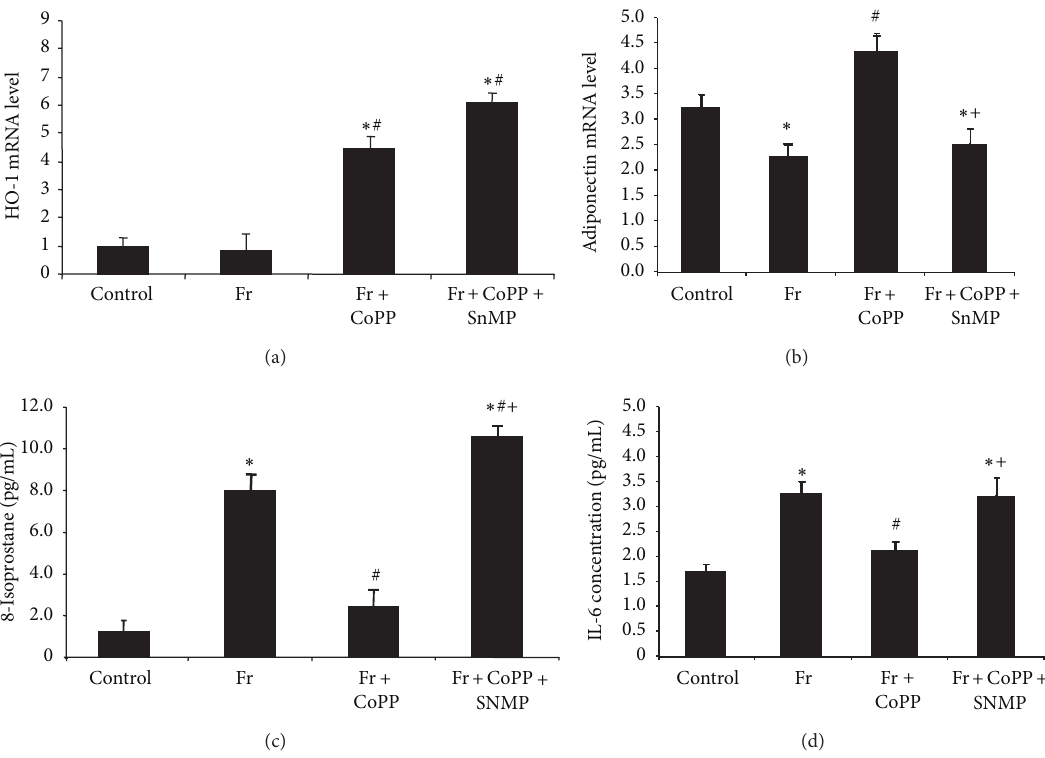
Figure 4: (a) Real-time PCR of HO-1 expression; (b) adiponectin expression; (c) concentration of 8-isoprostane in MSCs separated into control, fructose, fructose treated with CoPP, and fructose treated with CoPP and SnMP; and (d) concentration of IL-6 in conditioned media. Values represent means ± SEM of five independent treatments. ∗ 𝑃 < 0.05 versus control or # 𝑃 < 0.05 versus fructose or + 𝑃 < 0.05 versus fructose with